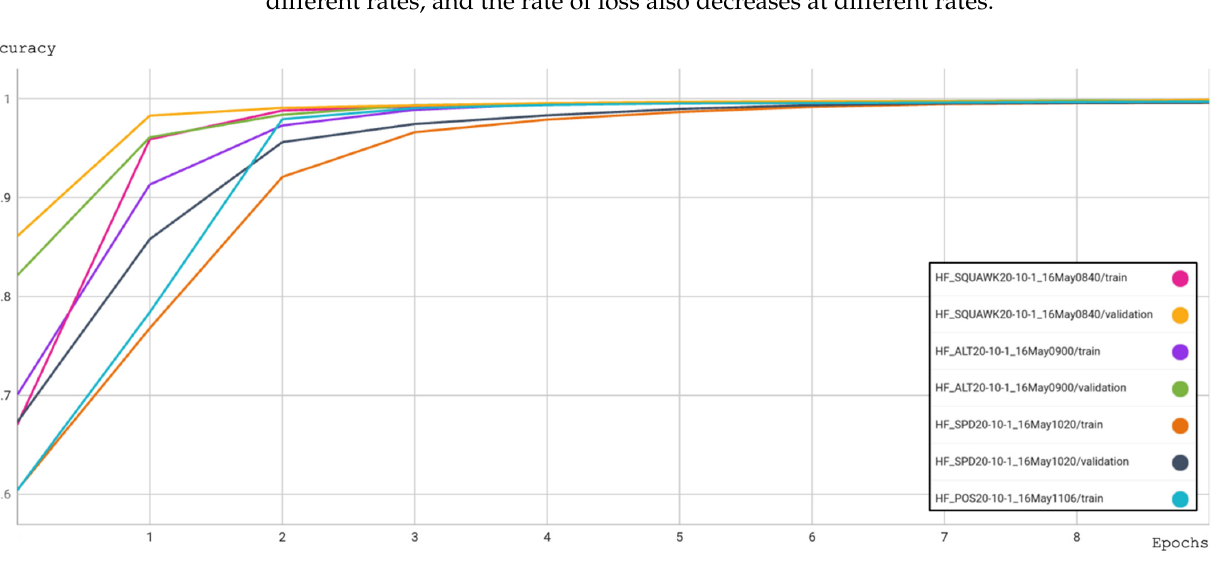
Figure 14. Human factors: model accuracy.